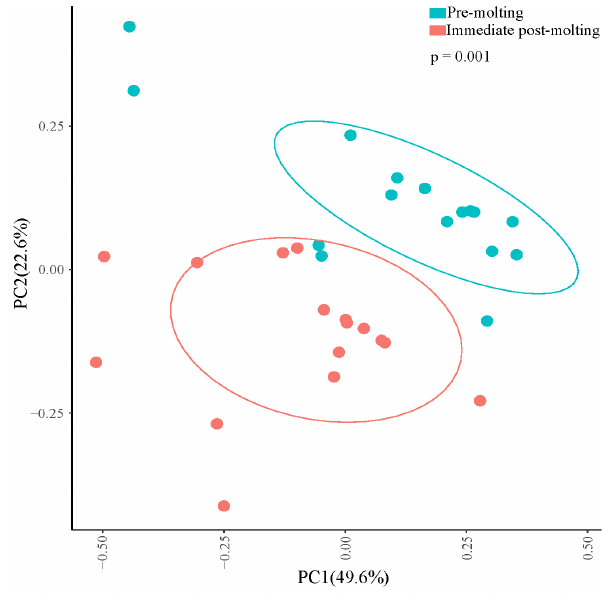
Figure 3. Jaccard distance based principal coordinate analysis (PCoA) plot of pre-molting and immediate post-molting. The divergence of forced molting on excreta bacterial community was statistically tested by analysis of similarity (ANOSIM; permutations = 999; ANOSIM’s r = 0.236, p<0.001). Percentages on the axes indicate variation explained by the principal coordinates of the jaccard distance and each symbol represents the bacterial community of each individual hen. Standard error ellipses represent 75% confidence areas. Pre-molting Immediate